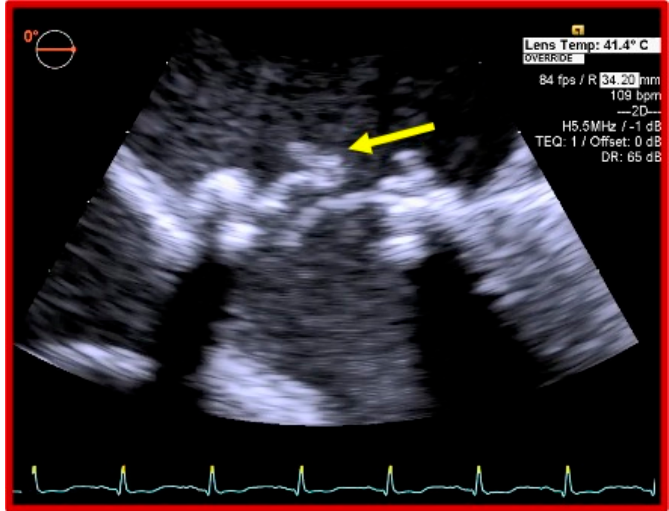
Figure 1. Two-dimensional transesophageal ECHO showing a flail leaflet of the bioprosthetic mitral valve.